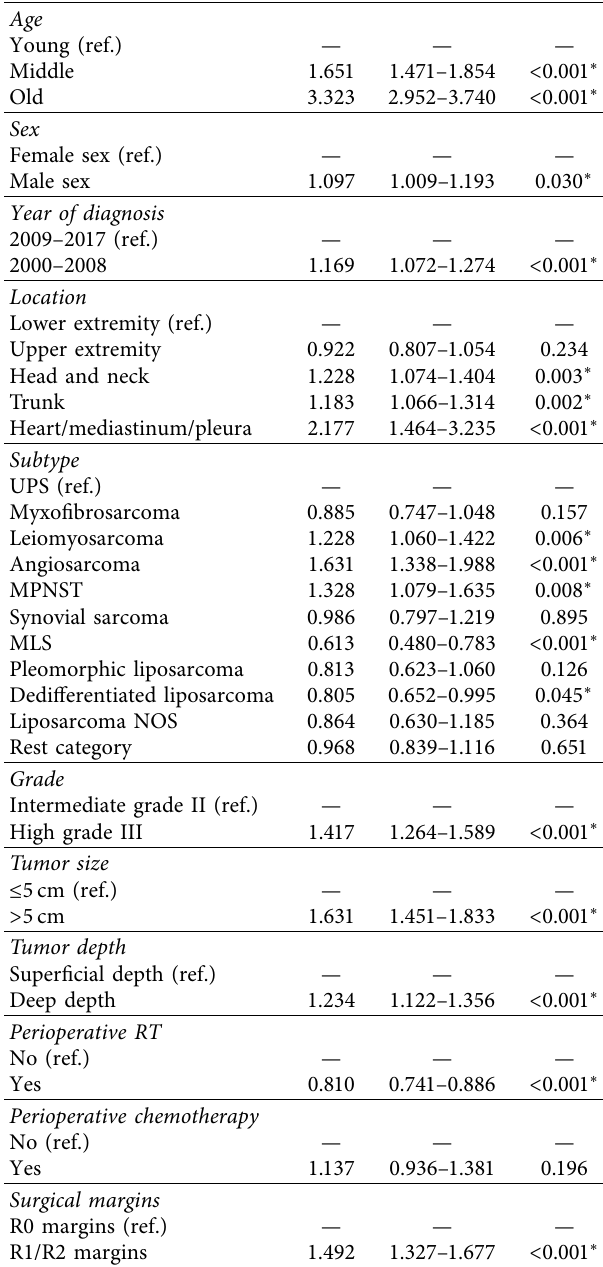
Table 6: Estimated hazard ratio (HR) along with 95% confidence interval from a multivariable Cox regression model on the asso- ciation between prognostic factors and overall survival for grades II and III resected STS in the Netherlands between 2000 and